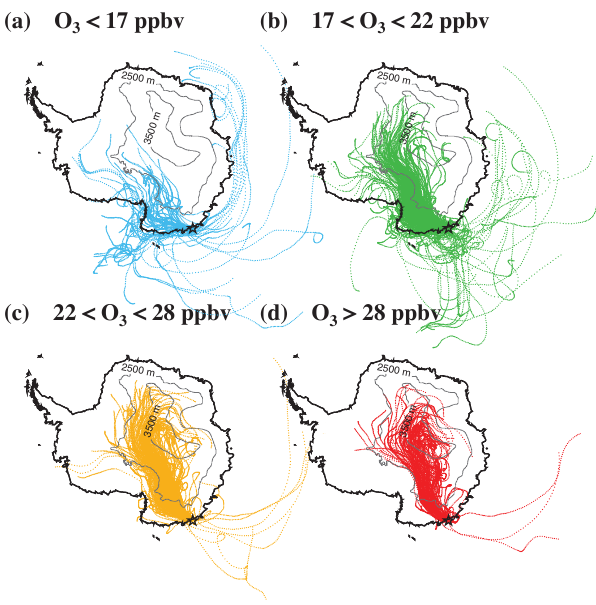
Figure 12. The 5-day backward trajectories for December at Du- mont d’Urville (from 2004 to 2014) corresponding to ozone mixing ratios of less than 17ppbv (blue lines in a ), ranging between 17 and 22ppbv (green lines in b ), between 22 and 28ppbv (yellow lines in c ), and higher than 28ppbv (red lines in d ). All lines correspond to arrivals at